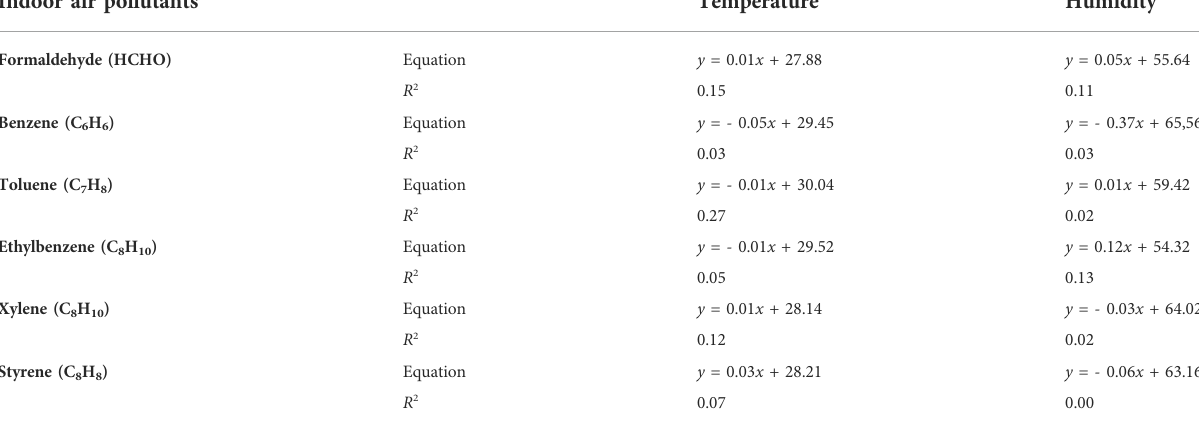
TABLE 6 Linear relationship between each chemical concentration and temperature and